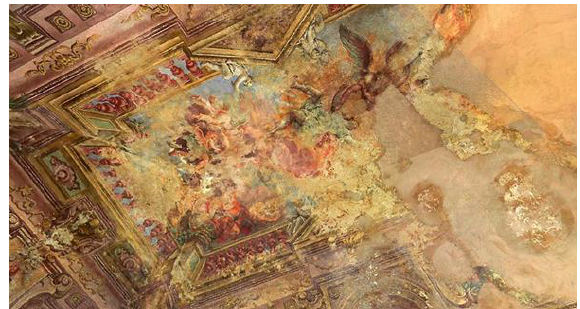
Figure 7. RGB three-dimensional view – 3d model of the vault elaborated with photogrammetry.